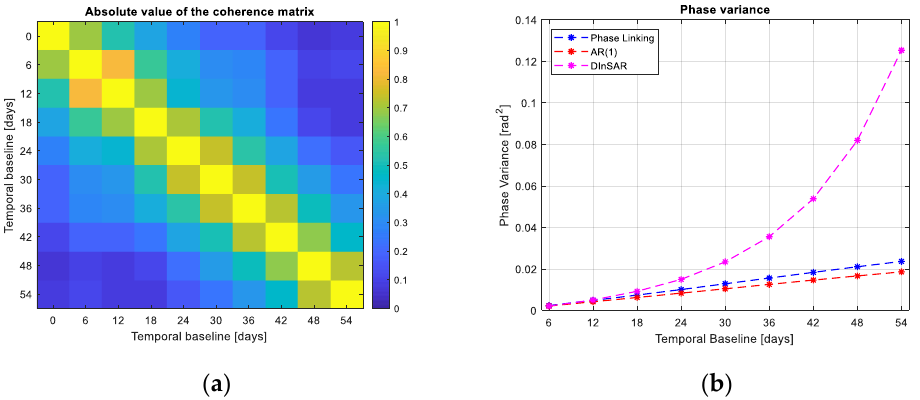
Figure 4. ( a ) coherence matrix for a distributed scatterer showing an exponential decorrelation with constant equal to 35 days. ( b ) phase variance using different estimators in the DS case.